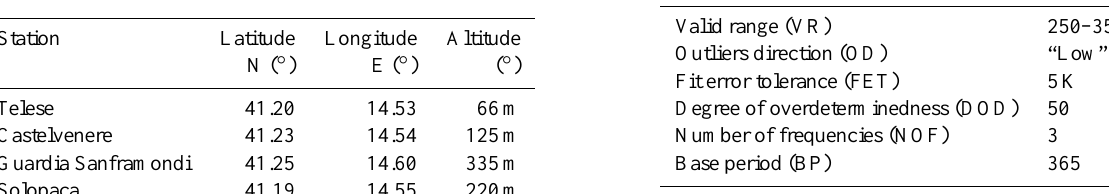
Table 1. Meteorological ground stations in the study area and be- longing to the Rete Agrometeorologica Regionale (Campania Re- gion).